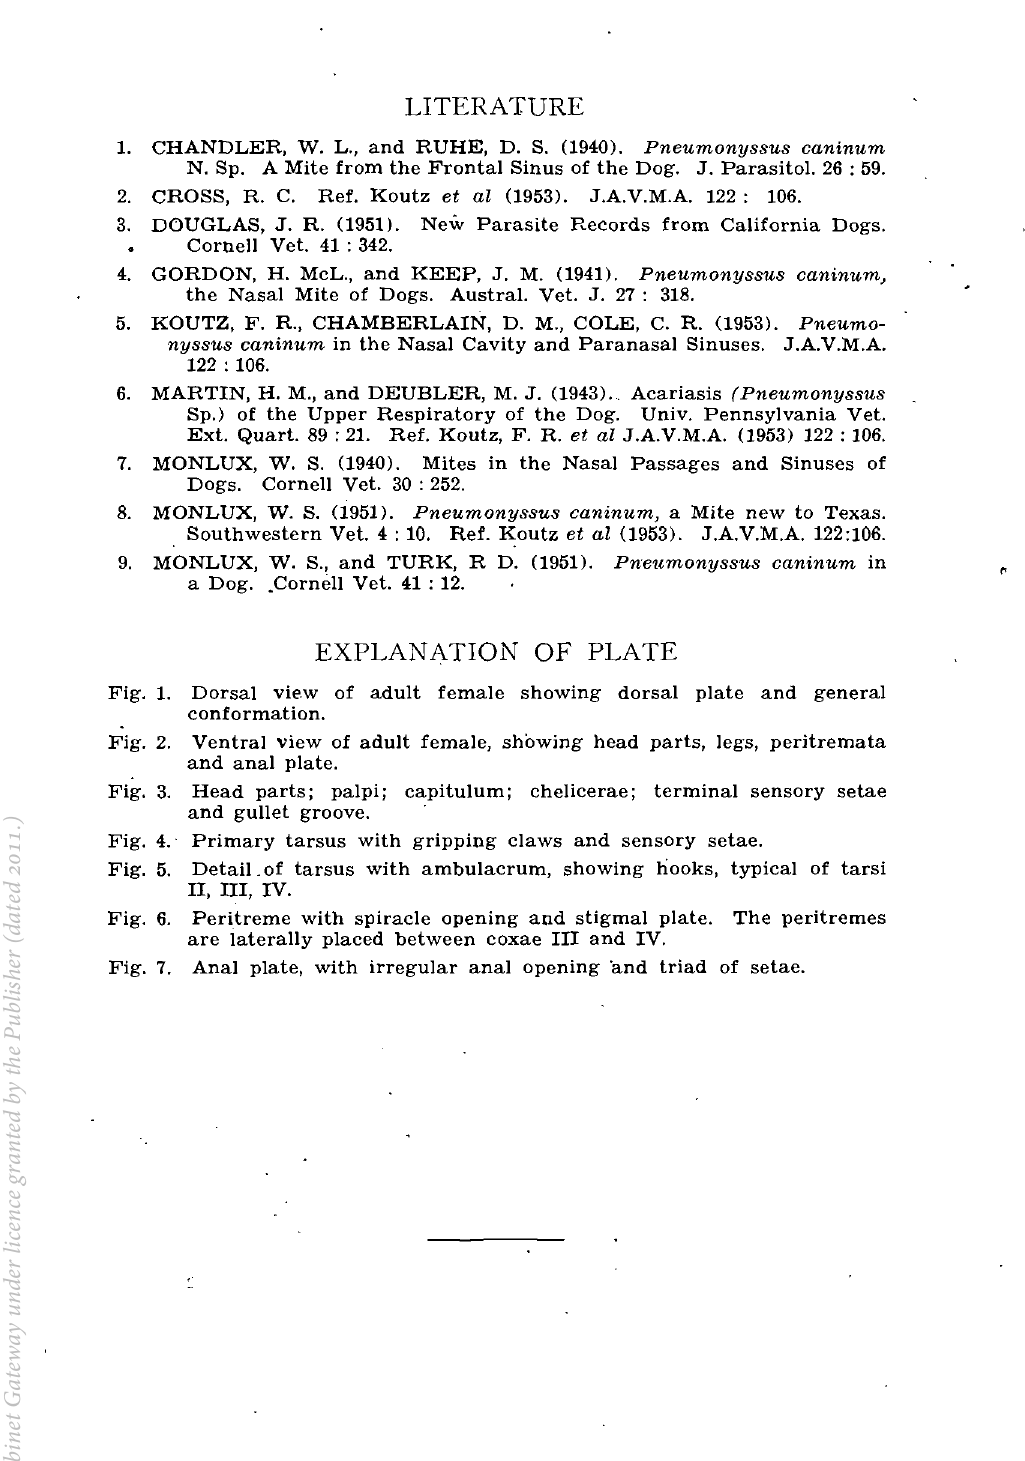
Fig. 1. Dorsal view of adult female showing dorsal plate and general conformation. Fig. 2. Ventral view of adult female, showing head parts, legs, peritremata and anal plate. Fig. 3. Head parts; pal pi; capitulum; chelicerae; terminal sensory setae and gullet groove. Fig. 4. Primary tarsus with gripping claws and sensory setae. Fig. 5. Detail.of tarsus with ambulacrum, showing hooks, typical of tarsi II, III, IV. Fig. 6. Peritreme with spiracle opening and stigmal plate. The peritremes are laterally placed between coxae III and IV. Fig. 7. Anal plate, with irregular anal opening 'and triad of setae,